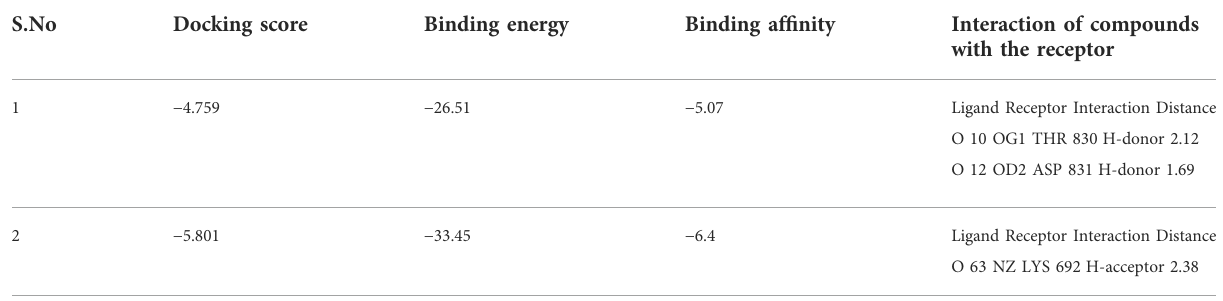
TABLE 6 Docking score, binding energies and Predicted interactions of compounds.